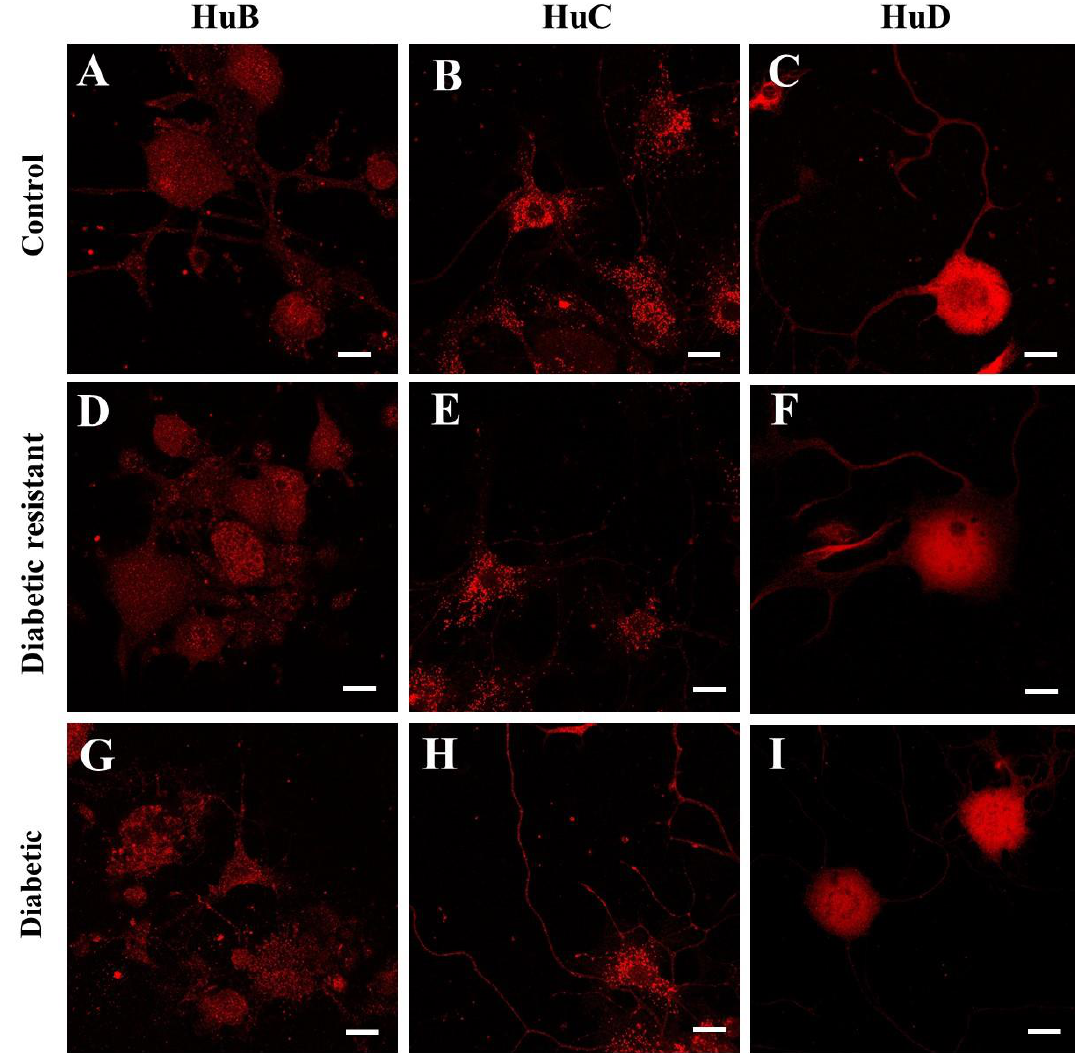
Figure 5. Hu proteins (HuB, HuC, and HuD ) expression in DRG neurons of control ( A – C ), diabetic resistant ( D – F ), and diabetic mice ( G – I ). The red labeling is obtained with rabbit polyclonal anti-ELAVL2, anti-ELAVL3, and anti-ELAVL4 antibodies, respectively, followed by the staining with donkey polyclonal anti-rabbit conjugated with Rhodamine Red X. Images are captured with an LSM 710 Zeiss laser scanning microscope using a 63× oil objective. Scale bar 10 μm.